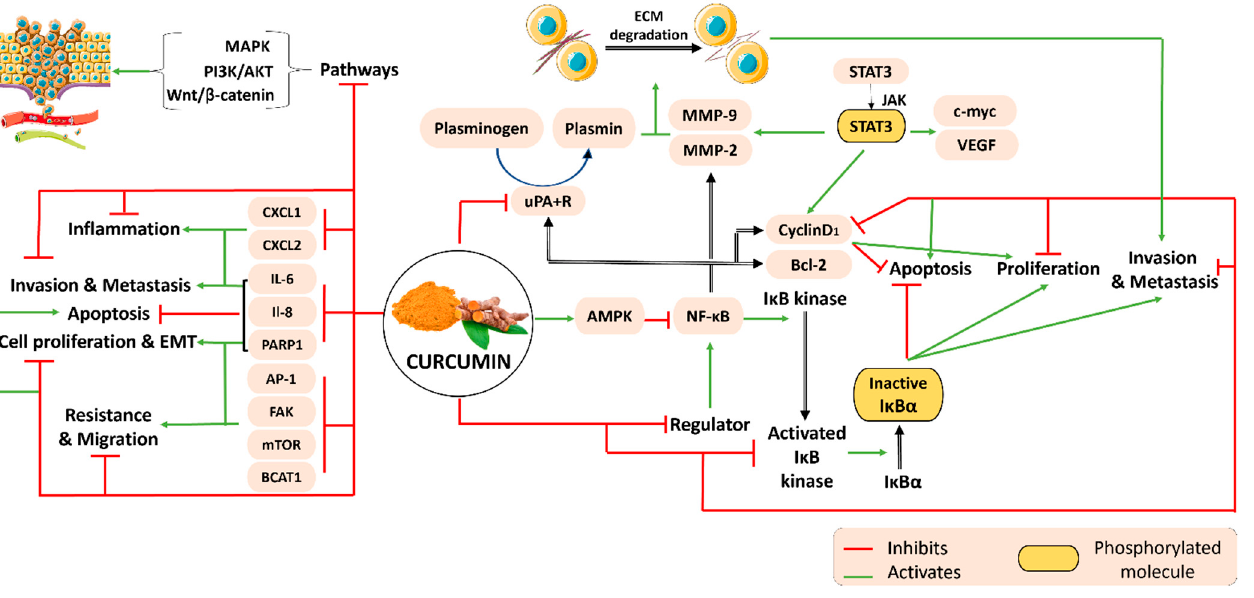
Figure 1. Molecular pathways underlying the anti-tumor properties of curcumin on various types of cancer. of